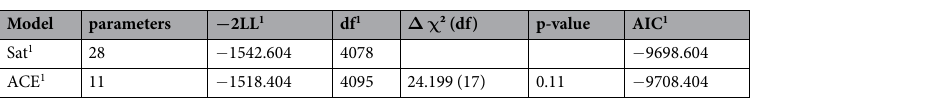
Table 3. Model fit statistics for saturated and bivariate model. 1 Abbreviations: 2LL: − 2 times log-likelihood of data; df: degrees of freedom; Δ χ ²: change in chi-square; AIC: Akaike’s Information Criterion; Sat: Saturated model; ACE: Full bivariate Correlation Factors